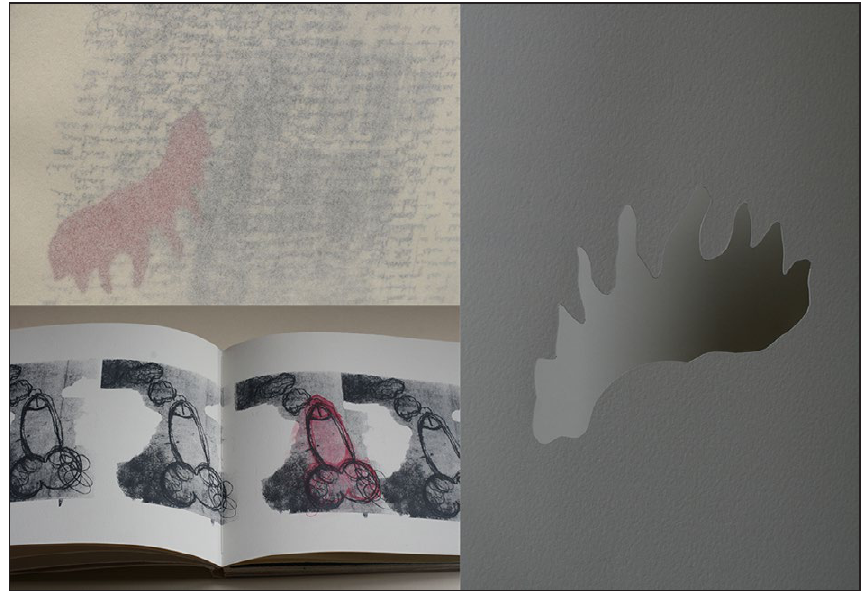
Figure 22: Helen Knowles, Cocks Comb , Screen Printed Artist Book made with Sal- ford Women’s Centre, 30 × 30 cm; Edition 1/1, Helen Knowles,